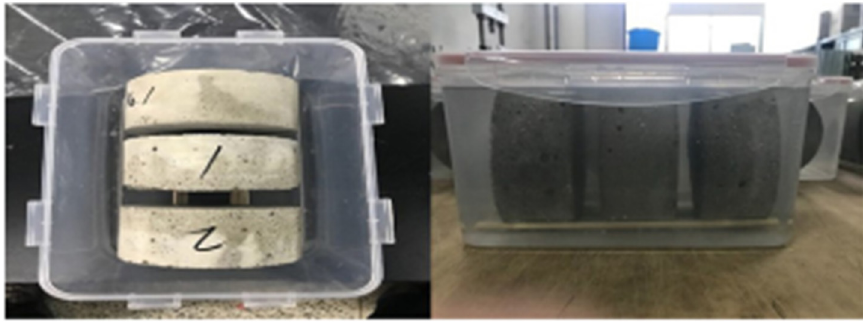
Figure 3. Sulfuric acid immersion test [39].